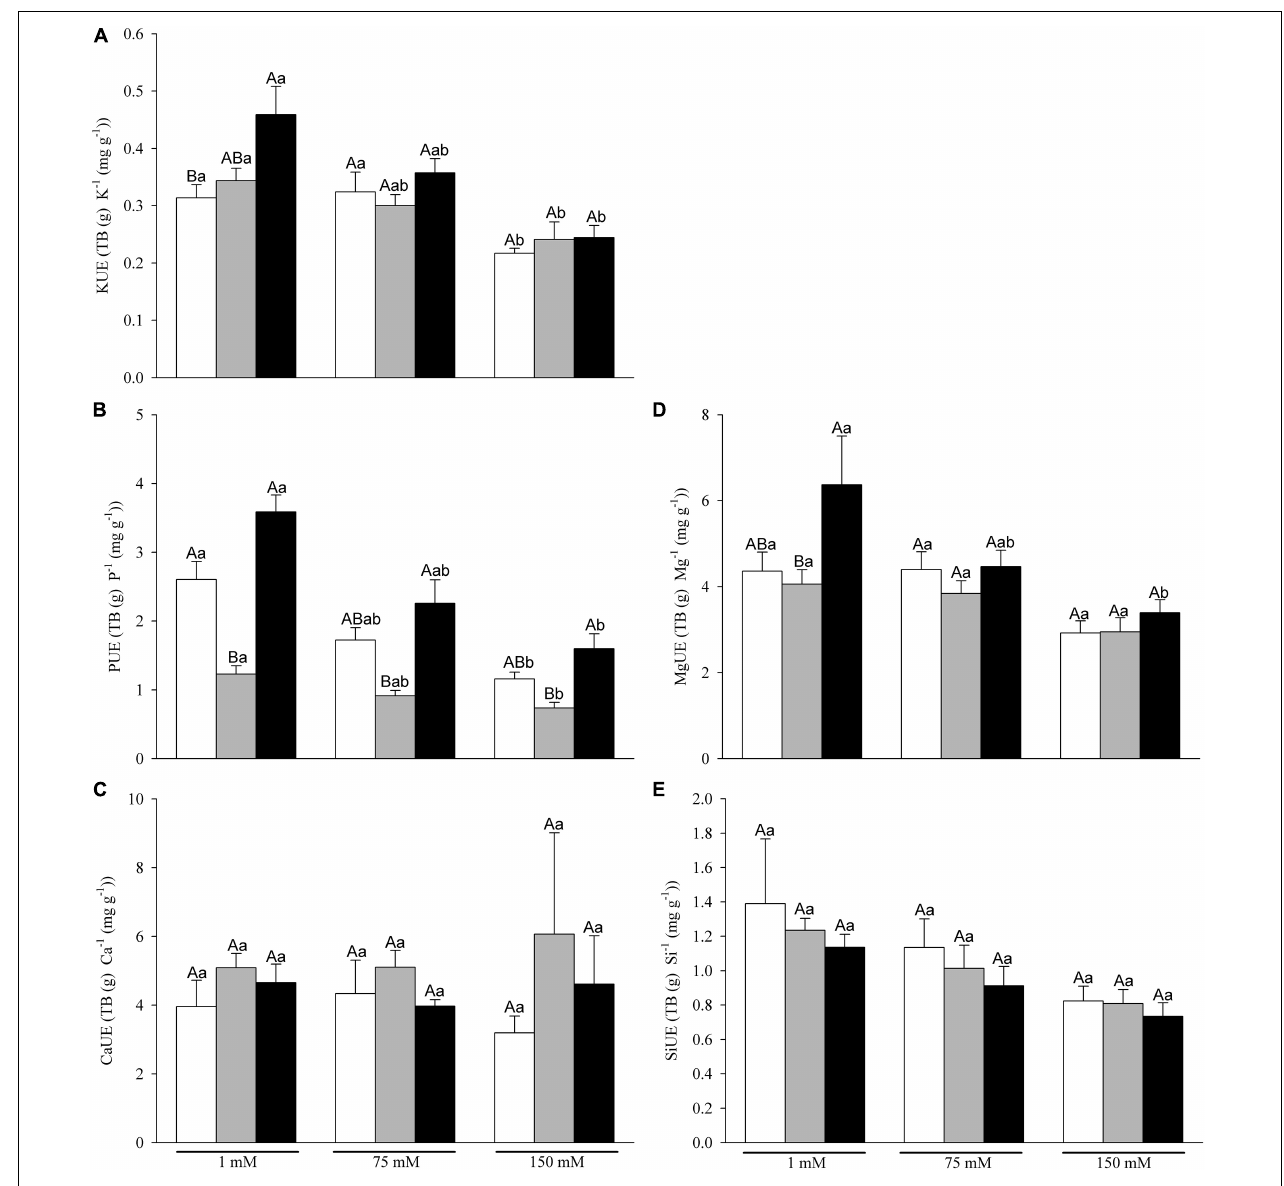
FIGURE 5 | Nutrient Use Efficiency [Total Biomass, TB (g)/nutrient concentration (mg g − 1 )]. (A) K + , KUE; (B) P, PUE; (C) Mg 2 + , MgUE; (D) Ca 2 + , CaUE and (E) Si, SiUE. Values are mean and SE of six replicates of of C, P and AM plants (white, gray and black bars, respectively) at the three salinity levels (1, 75 and 150 mM NaCl). Different capital letters indicate significant differences among nutritional levels (C, P and AM) within the same salt level, and lowercase letters indicate significant differences among salt levels within the same nutritional level, from post hoc Tukey